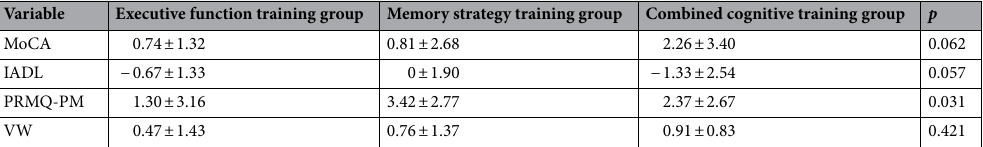
Table 8. Comparison of pre-test and follow-up difference between the three groups (mean [ M ] ± standard deviation [ SD ]). MoCA montreal cognitive assessment scale, IADL instrumental activities of daily living scale, PRMQ‑PM prospective and retrospective memory questionnaire-prospective memory, VW virtual week task. P for three group (executive function training group/memory strategy training group/combined cognitive training group) × 2 test time (pre-test/follow up-test)